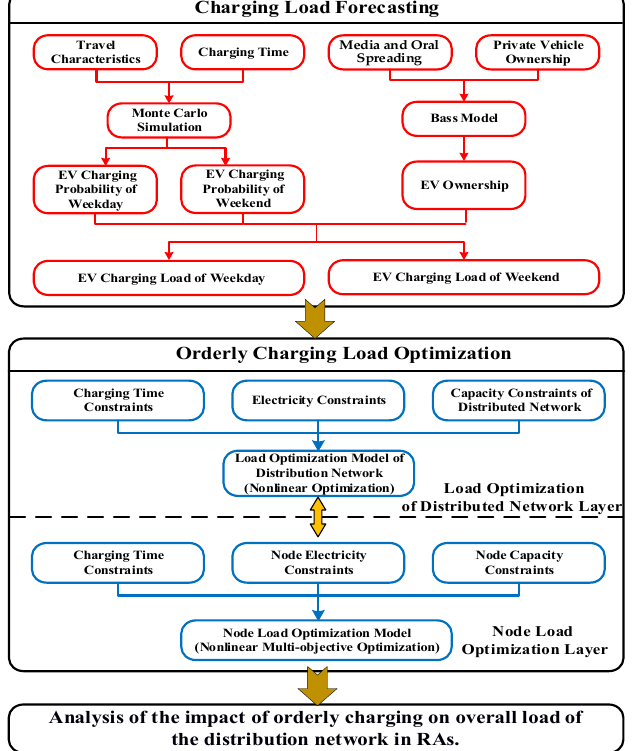
Figure 1. Architecture of mid-and long-term orderly charging load planning in RAs.